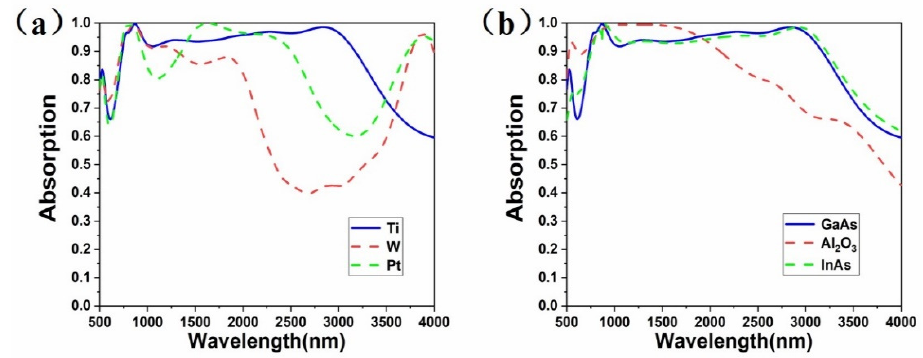
Figure 6. ( a ) Absorption curves of different metal materials. ( b ) Absorption curves of different semiconductor materials.